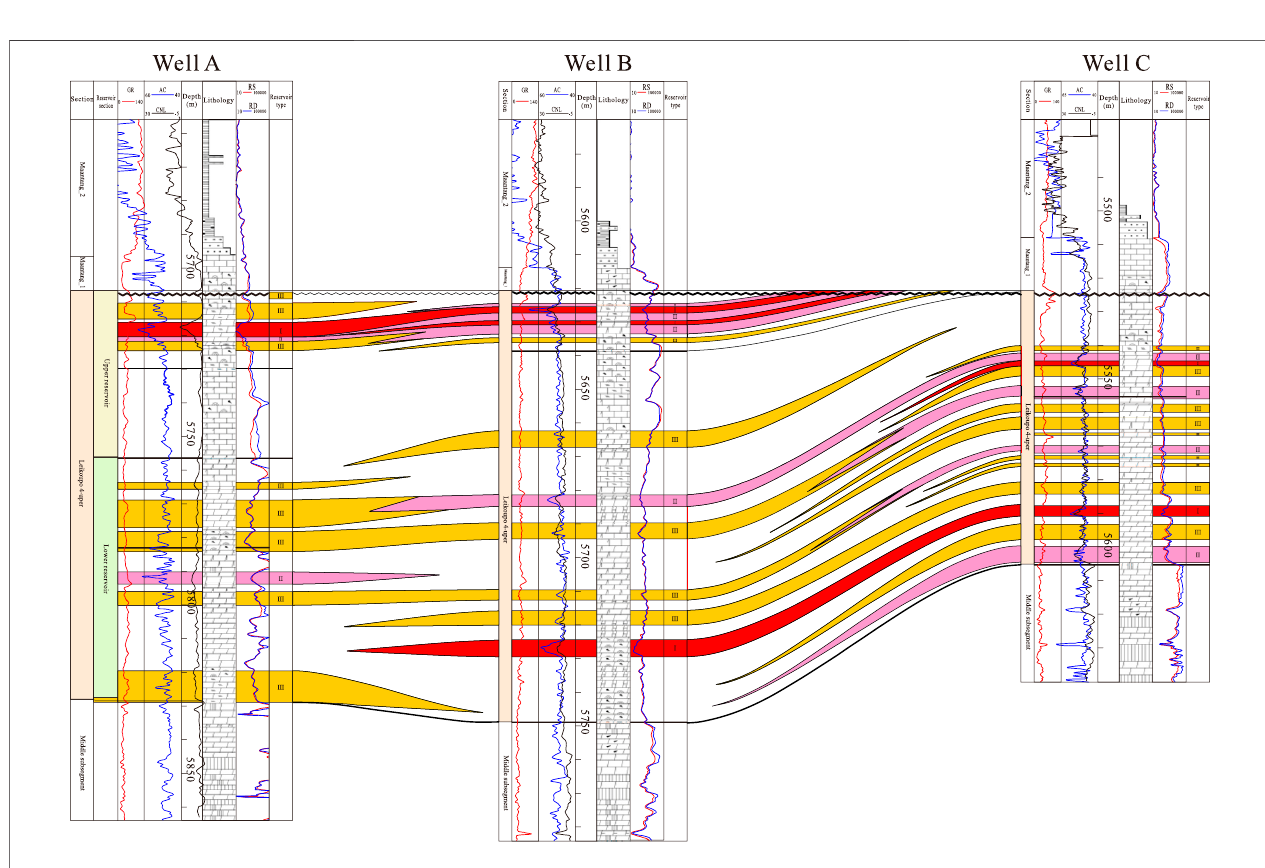
FIGURE 10 | Pro fi le of the drilled wells in the study